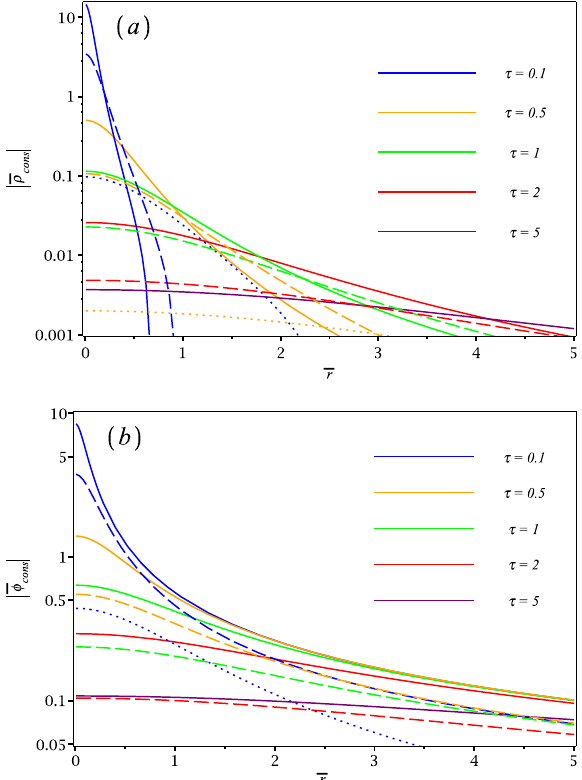
Figure 3. Conservative parts of ( a ) the induced charge density, ¯ ρ cons , and ( b ) the induced potential ¯ φ cons in the plane z = 0, with their absolute values shown on a logarithmic scale using reduced units against the dimensionless radial distance ¯ r for different dimensionless times ( τ = 0.1,0.5,1,2,5), with the damping parameter Γ = 0 and the reduced speeds ν = 1 (solid lines), ν = 2 (dashed lines) and ν = 10 (dotted